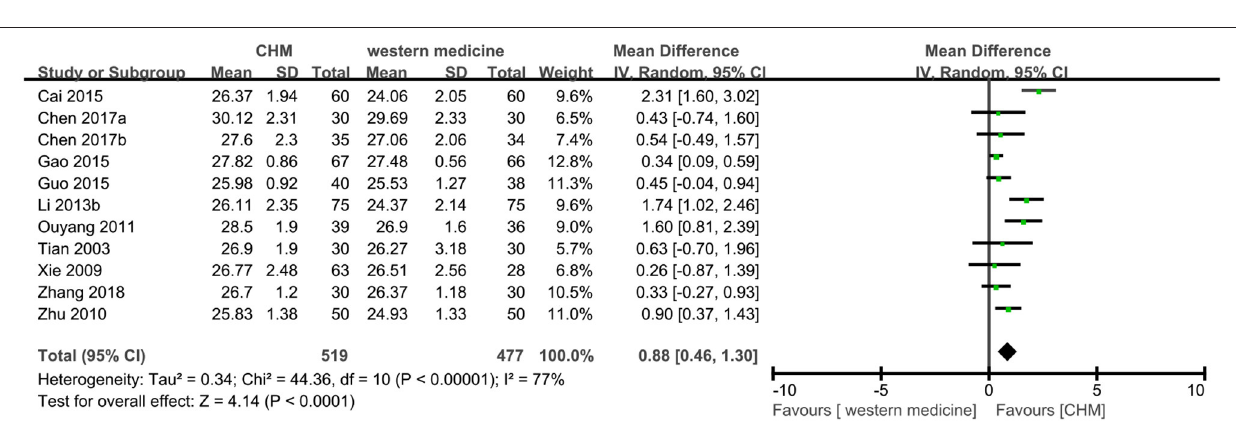
FIGURE 8 | Forest plot of comparison: CHM vs. western medicine, outcome: MMSE.